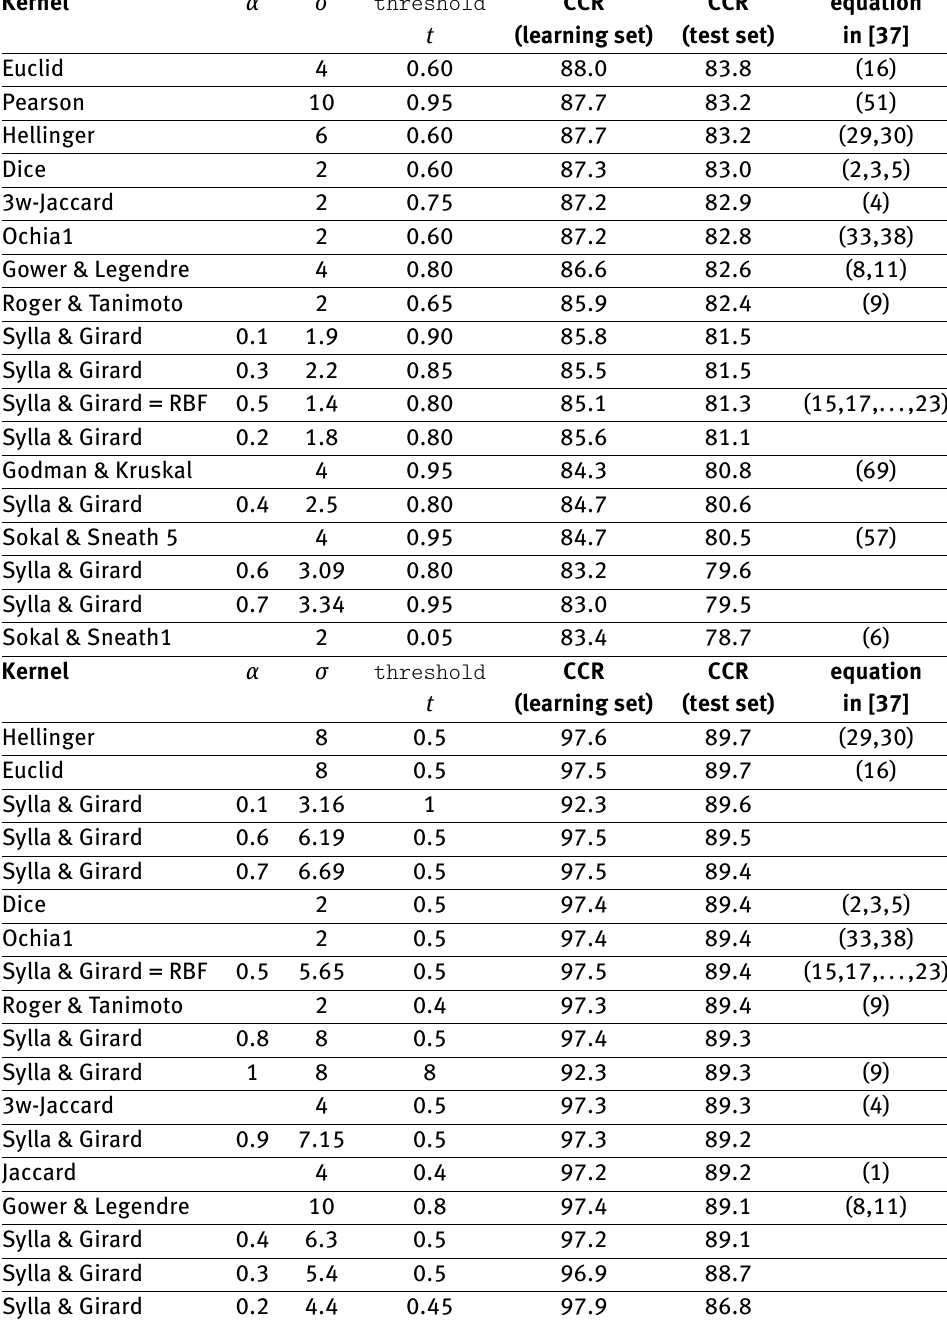
Table 2: Correct Classification Rate (CCR) on the verbal autopsy dataset (top) and on the handwritten digit dataset (bottom). The results are sorted by decreasing values of the CCR computed on the test set. The train set includes τ = 63% individuals from the initial dataset. The last column refers to the equation number in